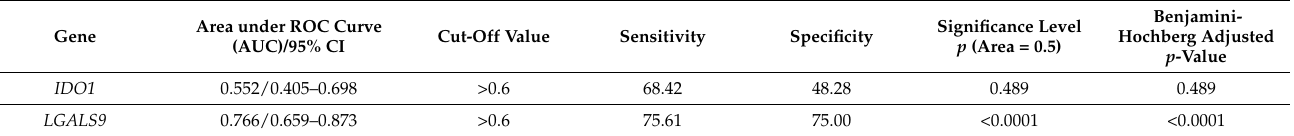
Table 5. The relationship of gene expression with the type by Lauren classification—ROC